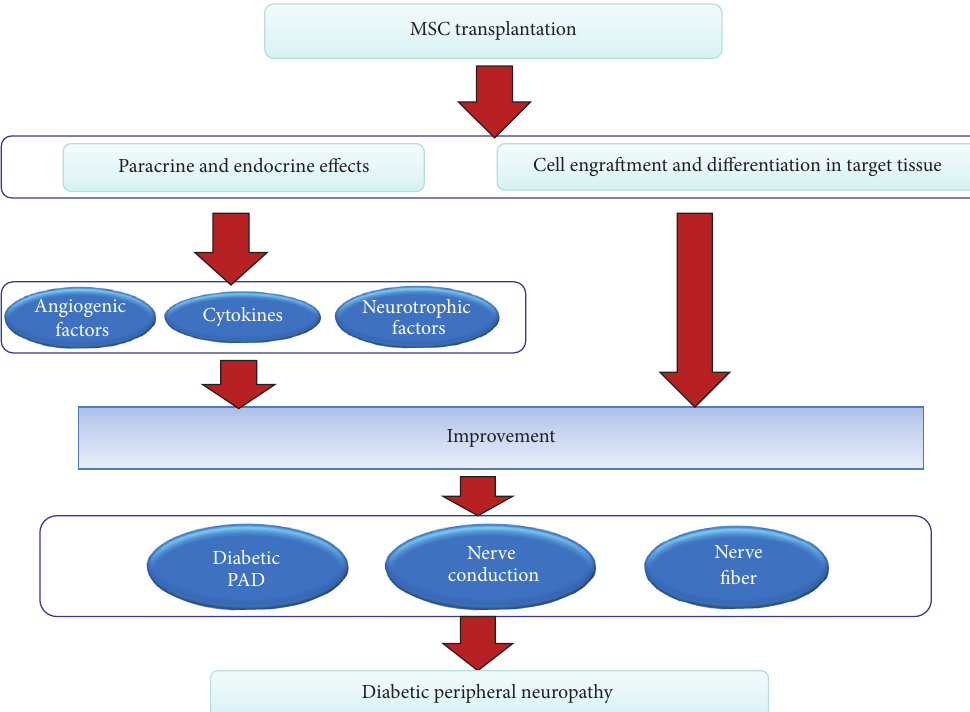
Figure 3: Mechanism of the effect of transplantation of MSCs on diabetic neuropathy. The mechanism of the recovery effect mediated by stem cell transplantation stems from two pathways: one is the secretion of angiogenic factors, cytokines, and neurotrophic factors and the other is the engraftment and differentiation of the cells into tissue constituents. Stem cells can specifically improve the local secretion and expression of angiogenic factors and cytokines, which contributes to the improvement of diabetic PAD and diabetes itself, in turn leading to the improvement of diabetic neuropathy. Neurotrophic factors can also ameliorate the dysfunction of nerve fibers and nerve conduction. Moreover, stem cells can differentiate into the target tissues to achieve a reparative